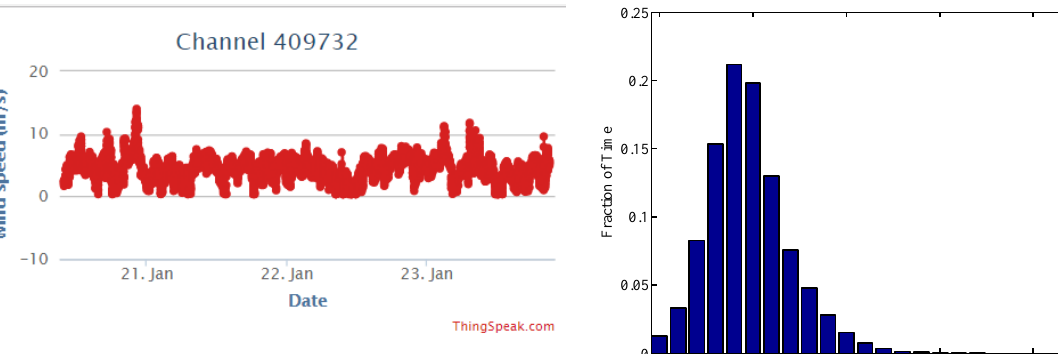
Figure 5: Wind speed using IoT.